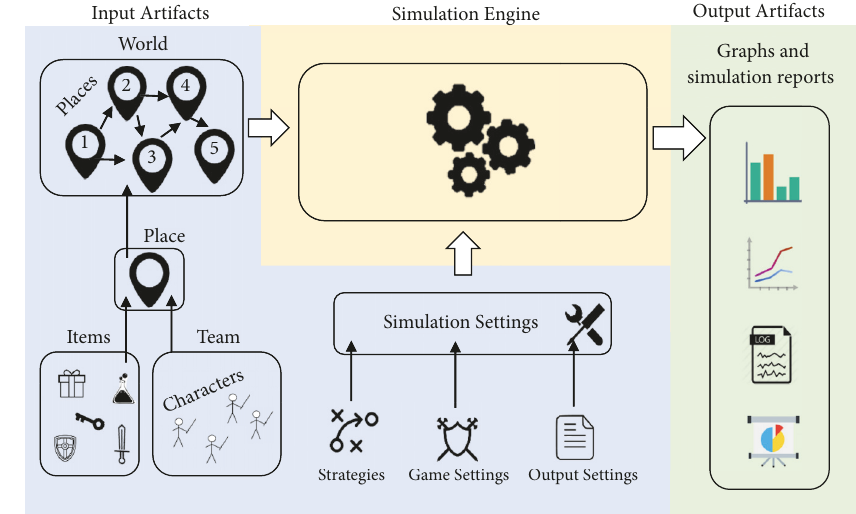
Figure 1: The simulation environment.